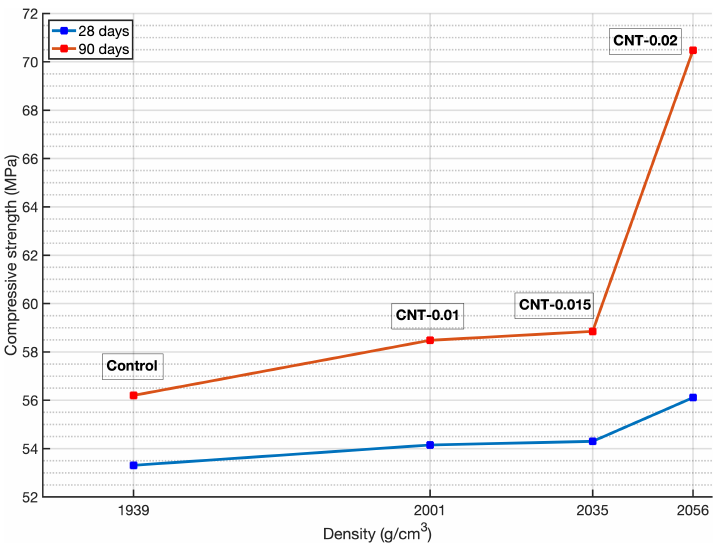
Figure 4. Relationship between compressive strength and density of MWCNT-mortar